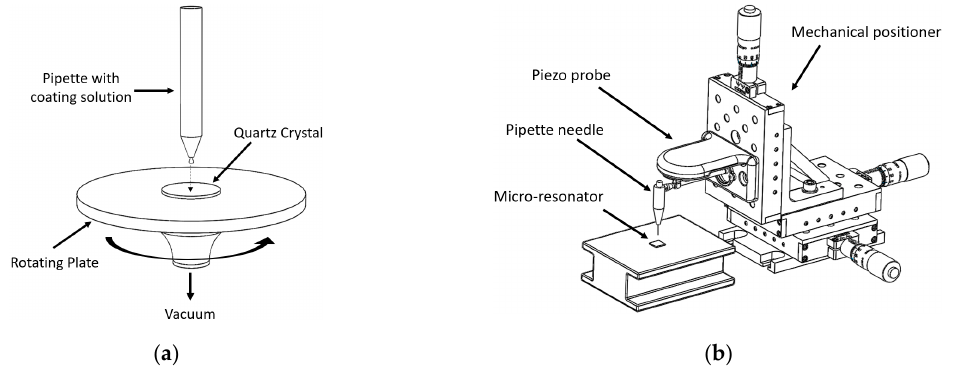
Figure 2. Coating deposition technique, ( a ) spin coater for the quartz crystal used for initial coating tests, ( b ) micro-drop deposition by piezo probe used for the micro-resonator sensor.